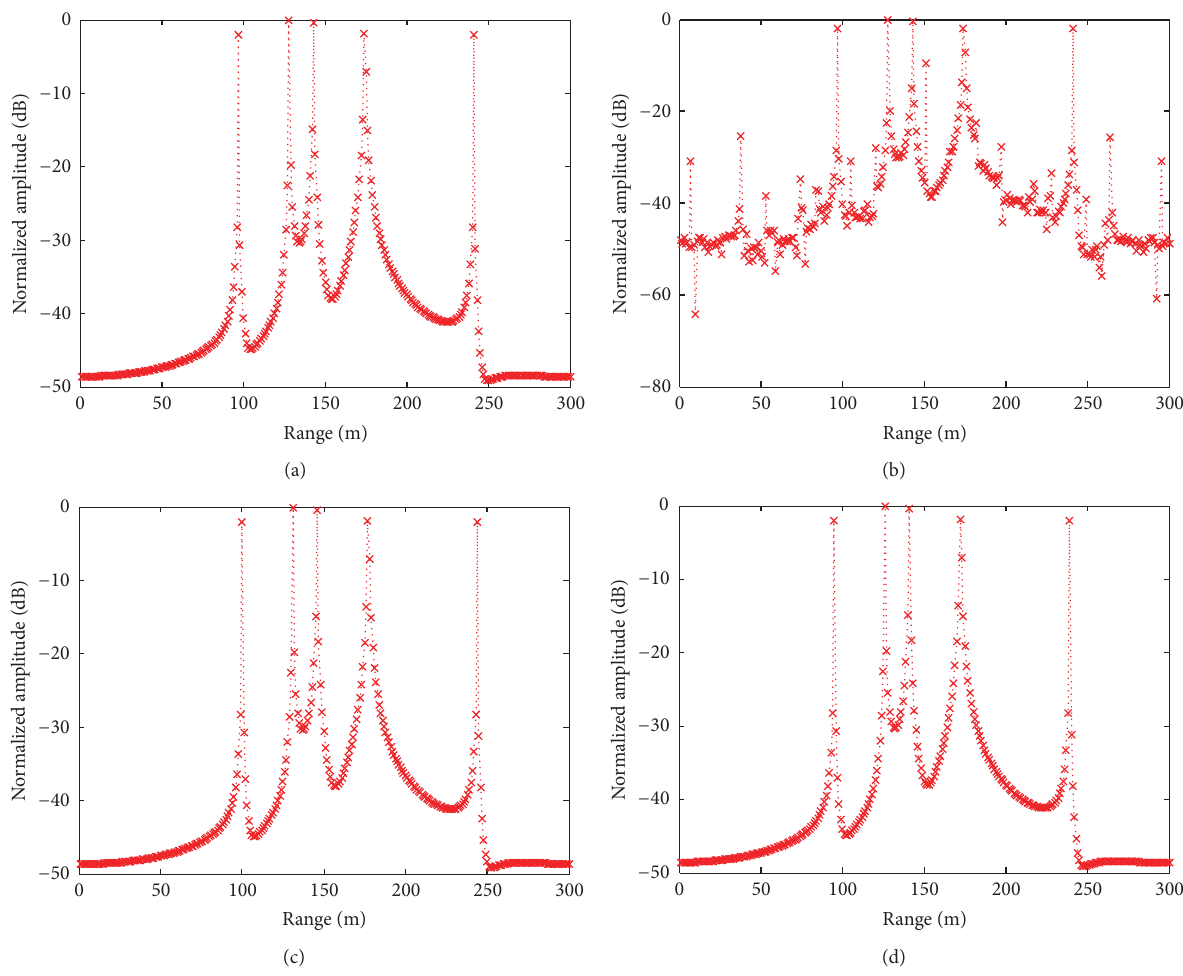
Figure 2: Illustration of the main drawbacks of traditional TDM for frequency stepped